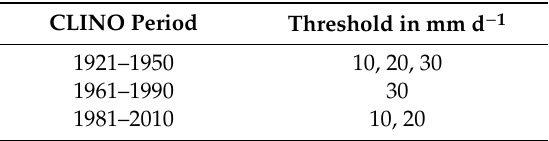
Table 2. Combinations of CLINO (Climate Normals) period and threshold with significantly di ff erent trends for stable and shifted stations in